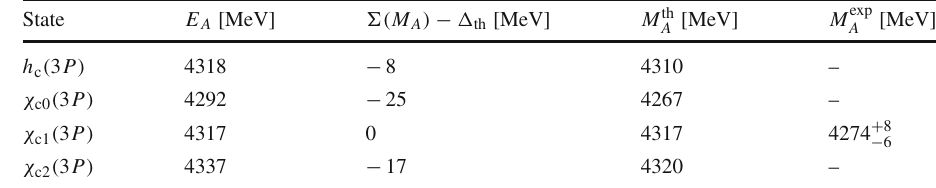
Table 4 Comparison between the experimental masses [1] of χ ( 3 P ) states and our c theoretical predictions, as explained in the text. The bare mass values, E A , are extracted from Refs. [69,77]